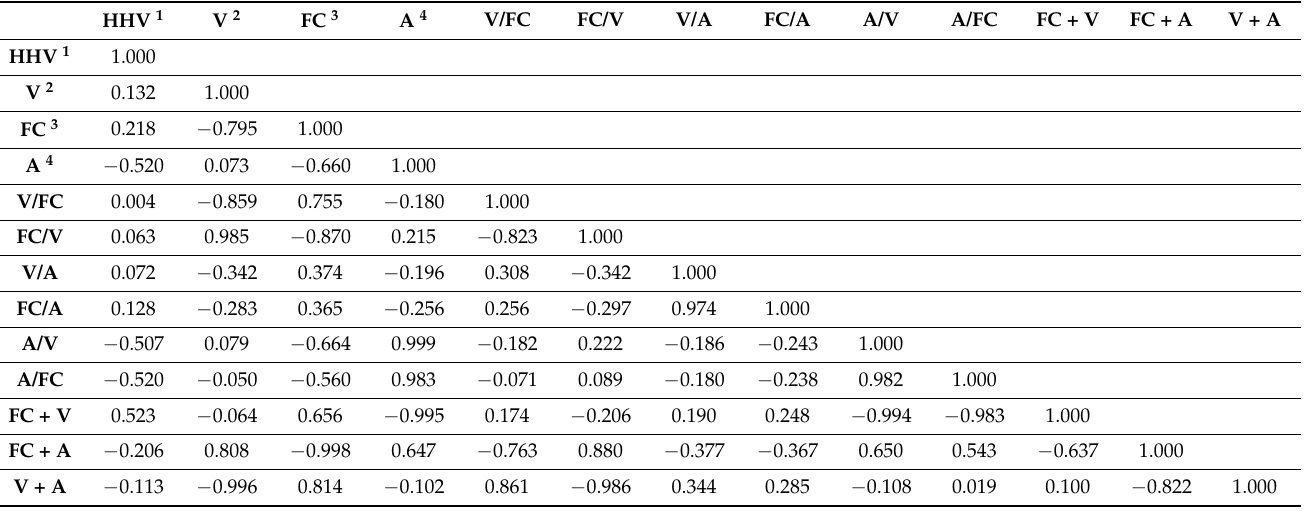
Table 5. Pearson’s test for experimental results from the proximate